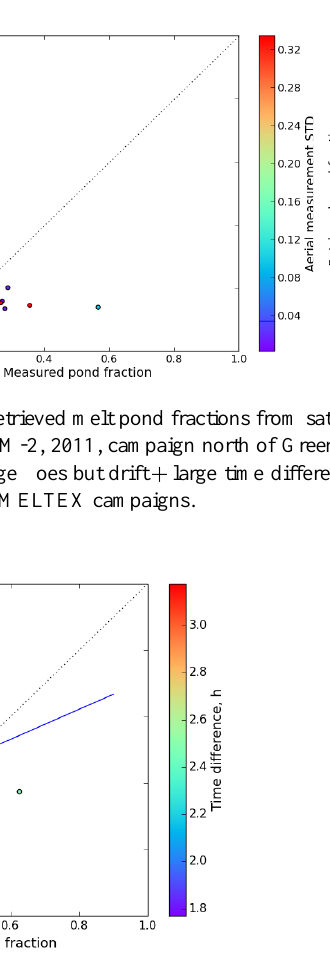
Figure 11. Altitude of the airborne melt pond measurements on 6 June 2008 (left panel). Correlation between retrieved melt pond fractions from satellite and airborne classified MPF over landfast ice with no drift (right panel), 6 June 2008 during MELTEX campaign. The flight track shown on the top panel Fig. 9. N = 48, R 2 = 0.36, RMS = 0.154.